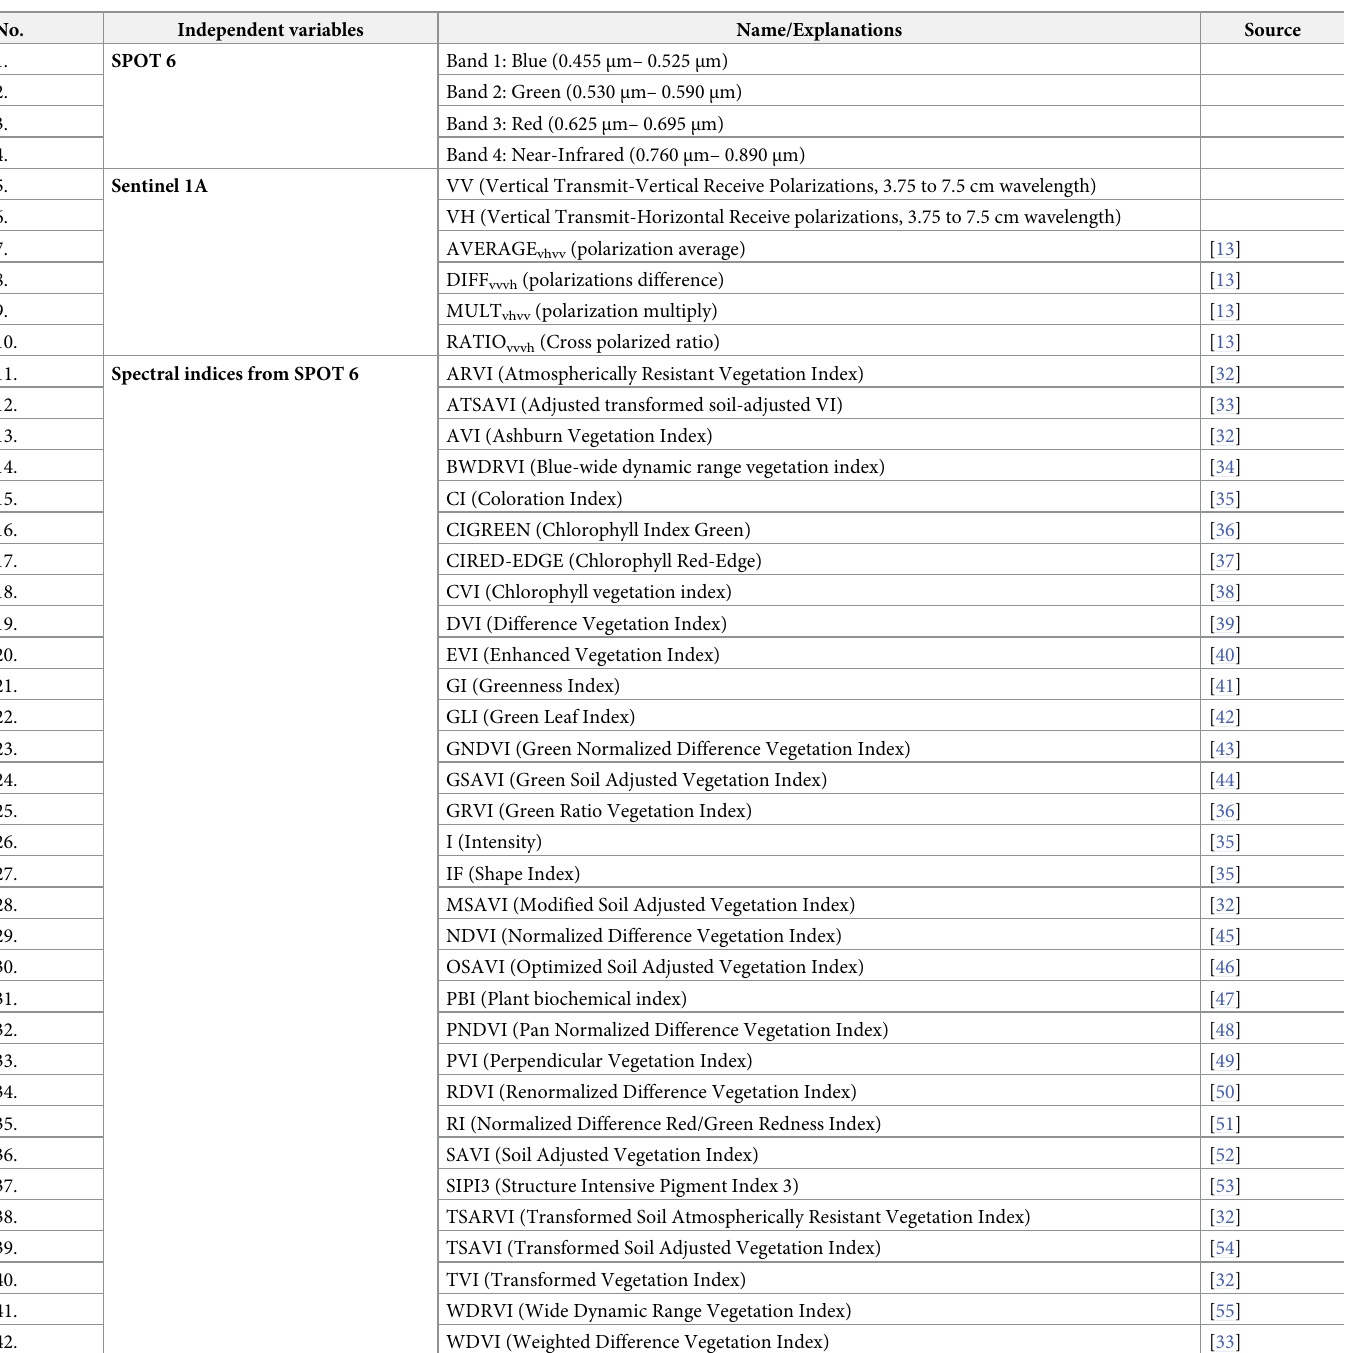
Table 1. Predictor variables from Sentinel-1A and SPOT-6.